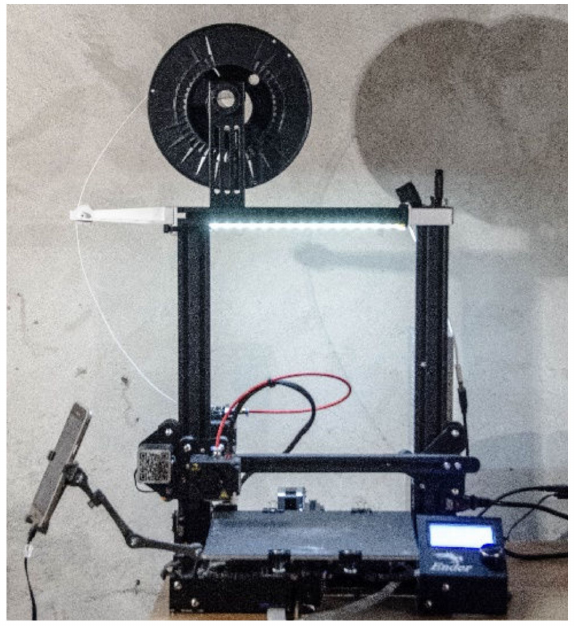
Figure 4. The Creality Ender 3 printer used to produce the specimens. The G-code file was generated in Ultimaker Cura version 4.13.1 (Ultimaker, Utrecht, The Netherlands) for the built-in device profile and modified settings for material, structure and device movements. Grid fill type was assumed. It is a truss-like structure, consisting of two sets of intersecting walls at right angles at a constant distance from each other, creating empty areas of cuboids with a square base (Figure 5). This structure does not change along the Z axis.